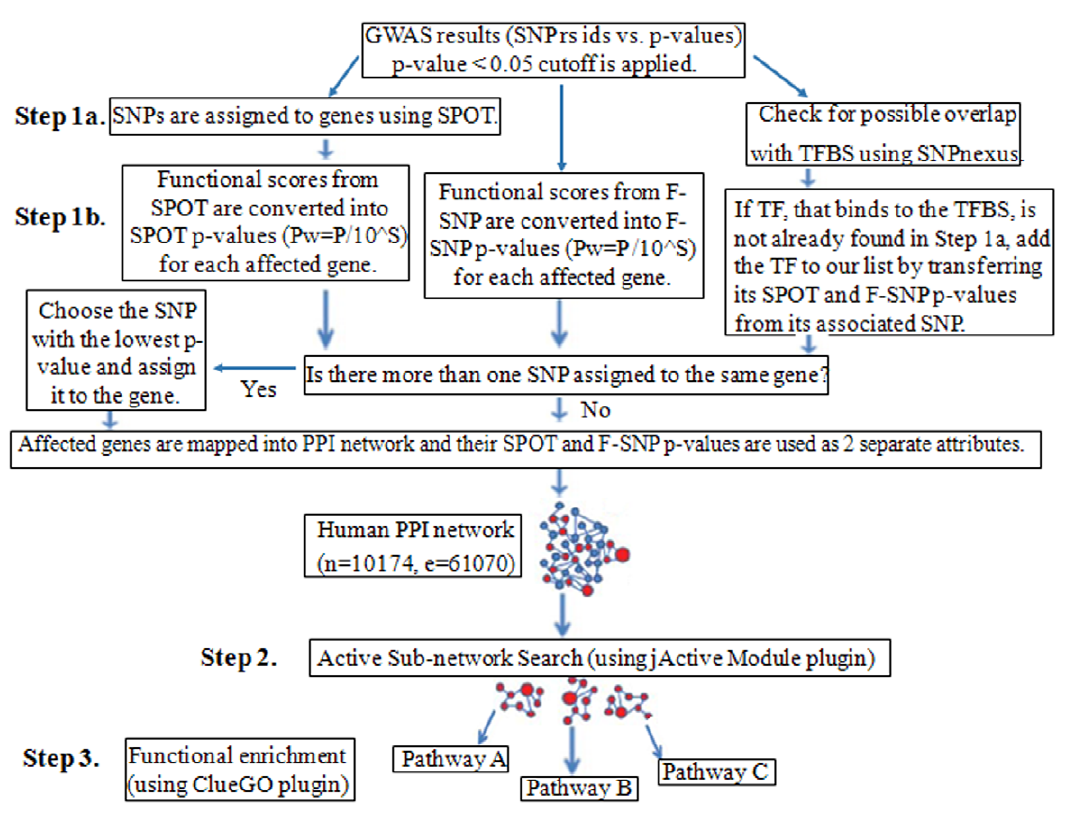
Figure 1. Outline of our assessment process. In Step 1, a gene-wise Pw-value for association with disease was computed by integrating functional information. In Step 2, significant Pw-values were loaded as two separate attributes of the genes in a PPI network and visualized using Cytoscape [23]. At this step, active sub-networks of interacting gene products that were also associated with the disease, are identified using jActive Modules plugin [24]. In Step 3, genes in an identified active sub-network were tested whether they are part of functionally important KEGG pathways.